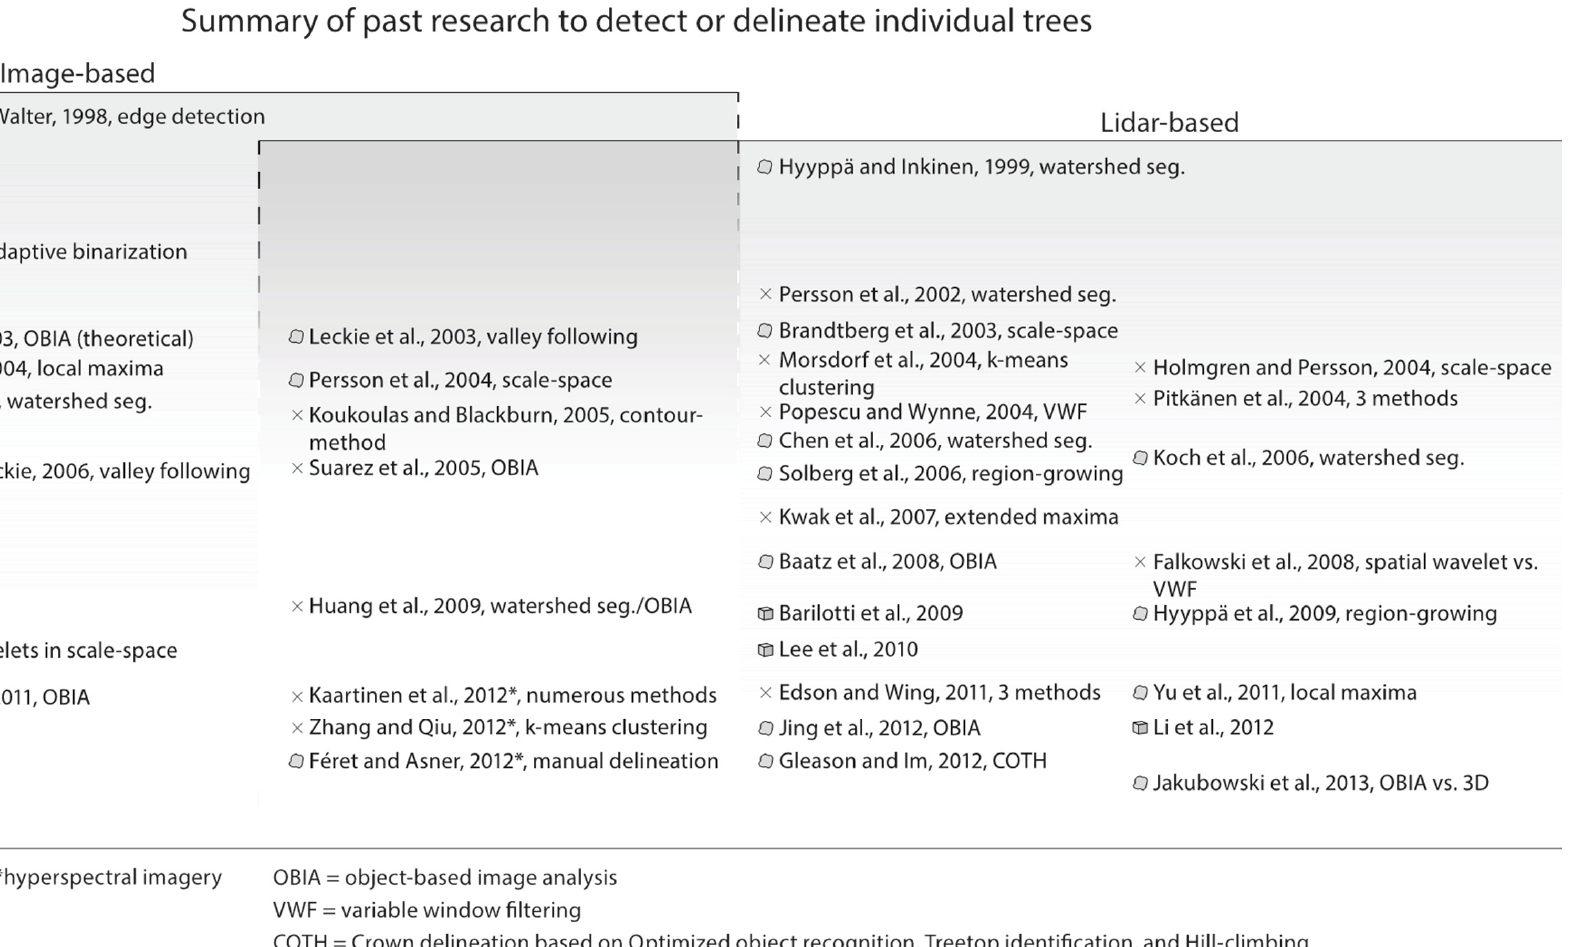
Figure 1. Past studies that detect or delineate individual trees from either imagery, lidar, or their combination. The published work is arranged by year, from top to